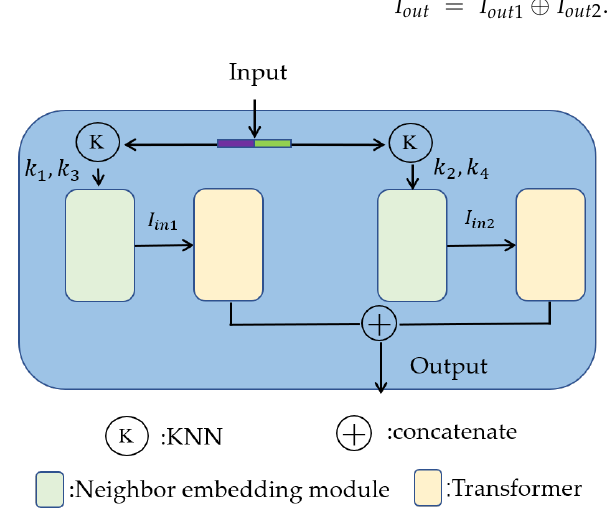
Figure 8. Parallel encoder layer.